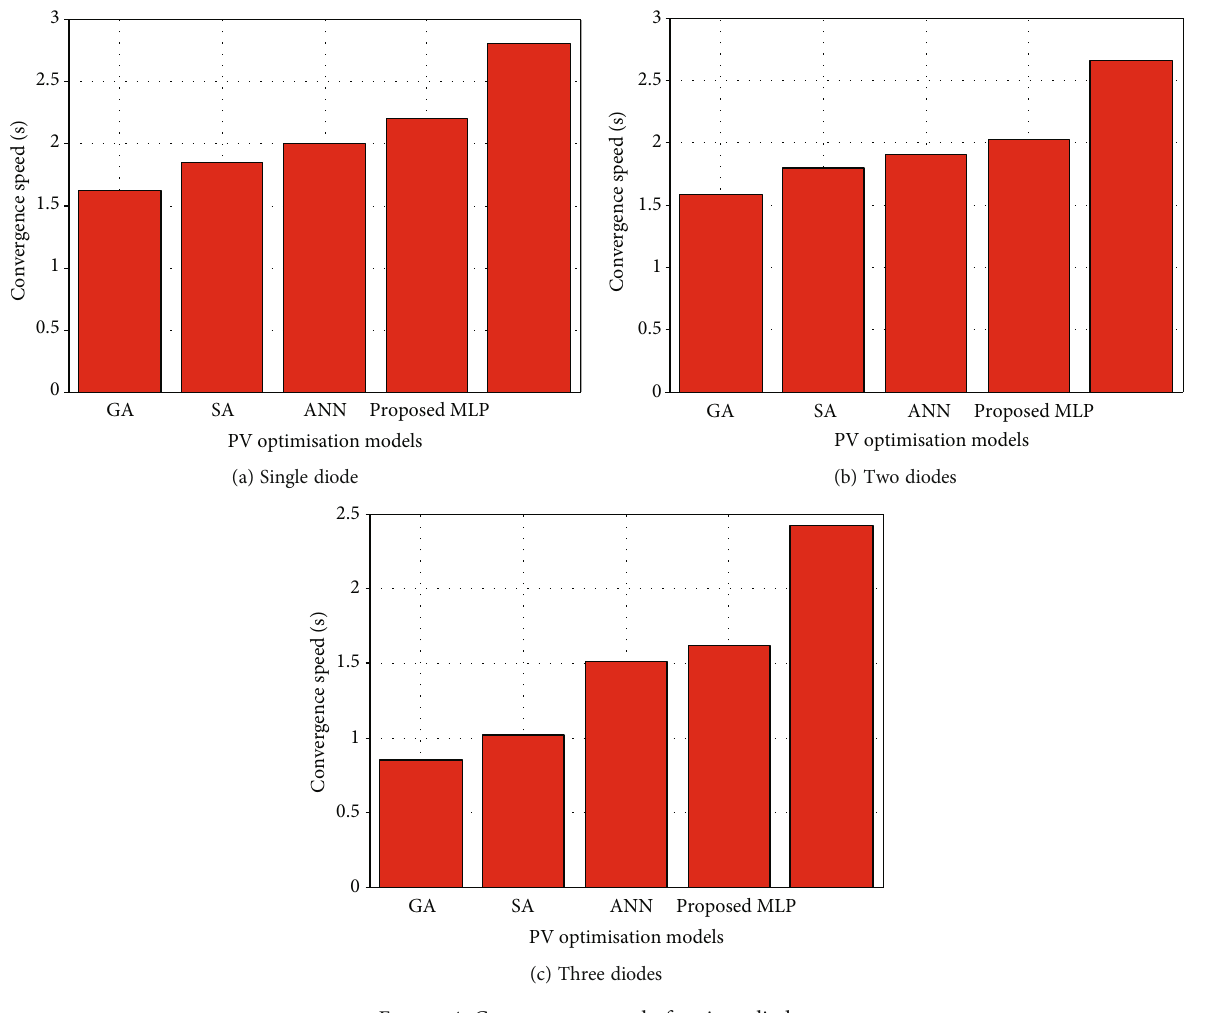
Figure 4: Convergence speed of various